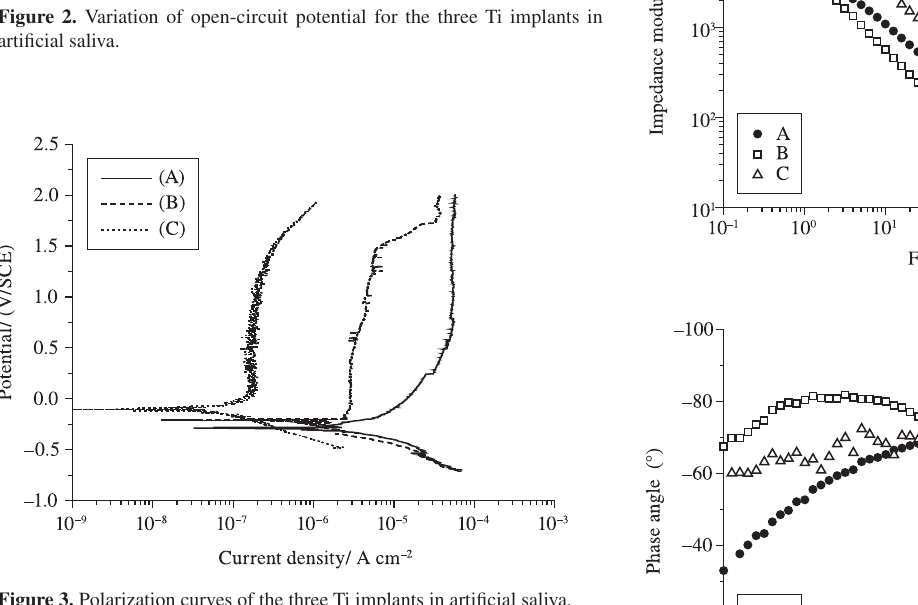
Figure 3. Polarization curves of the three Ti implants in artificial saliva.